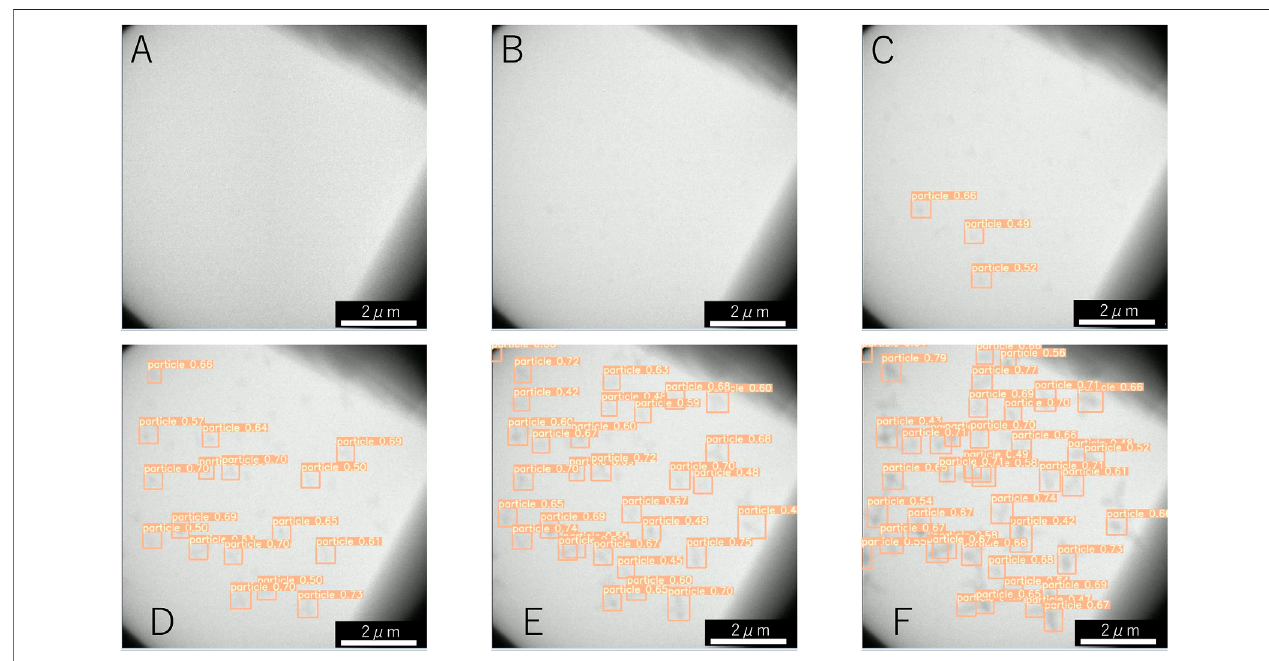
FIGURE 4 | Detection of NaCl particles with dendritic shape by machine learning at (A) 0.1 s, (B) 0.4 s, (C) 0.6 s, (D) 1.5 s, (E) 2.5 s, and (F) 5.5 s. The time of 0 s corresponds to the start of electron irradiation.